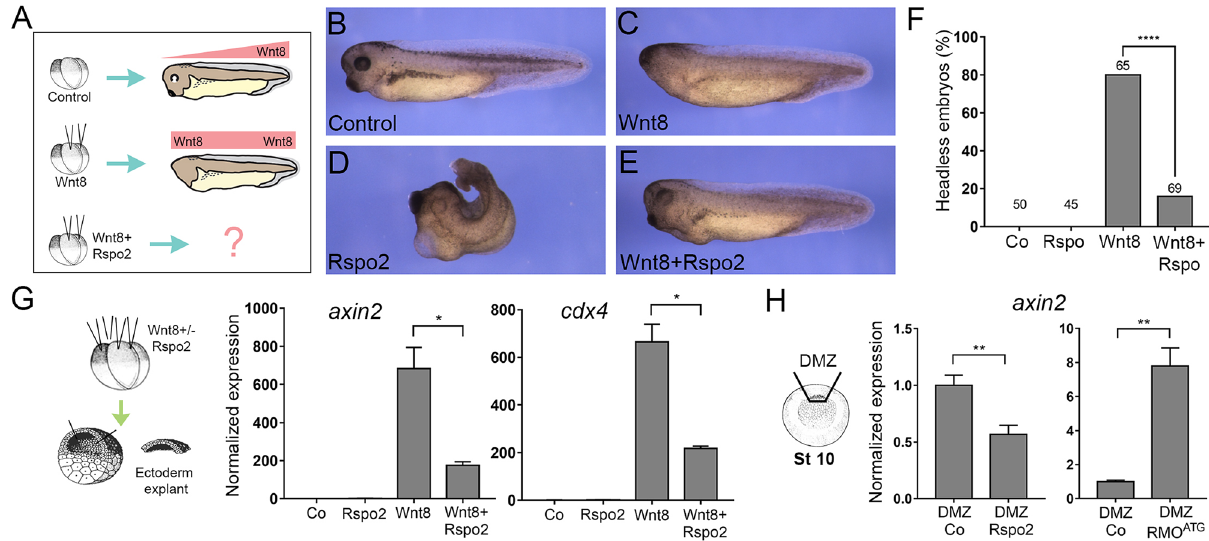
Figure 2. Rspo2 antagonizes Wnt signaling. ( A ) Scheme of the experiment. Four-cell embryos were injected animally into both dorsal blastomeres with the indicated constructs and cultured to stage 38. ( B ) Uninjected control embryo. ( C ) Headless embryo injected with Wnt8 DNA (50 pg). ( D ) Embryo injected with Rspo2 RNA (0.5 ng). ( E ) Embryo coexpressing Wnt8 DNA and Rspo2 mRNA. ( F ) Quantification of the data in ( A – D ) representative of 3 independent experiments. Numbers of embryos per group are shown above each bar. ****, p < 0.0001, Fisher’s exact test. ( G ) Target gene expression in Wnt8 and Rspo2-stimulated ectoderm explants. Embryos were injected into four animal blastomeres with Wnt8 DNA (50 pg) and Rspo2 RNA (0.5 ng), as indicated, and ectoderm explants were prepared at stage 9 and cultured until stage 13. ( H ) Dorsal marginal zones (DMZ) were dissected at stage 10 from the control and Rspo2 RNA- or RMO ATG -injected embryos and cultured until stage 12. ( G , H ) RT-qPCR analysis was carried out in triplicates for axin2 and cdx4 , and normalized to eef1a1 levels . Means + /− s.d. are shown. Graphs are representative of three independent experiments. Statistical significance has been assessed by Student’s t test, *, p < 0.05; **, p <